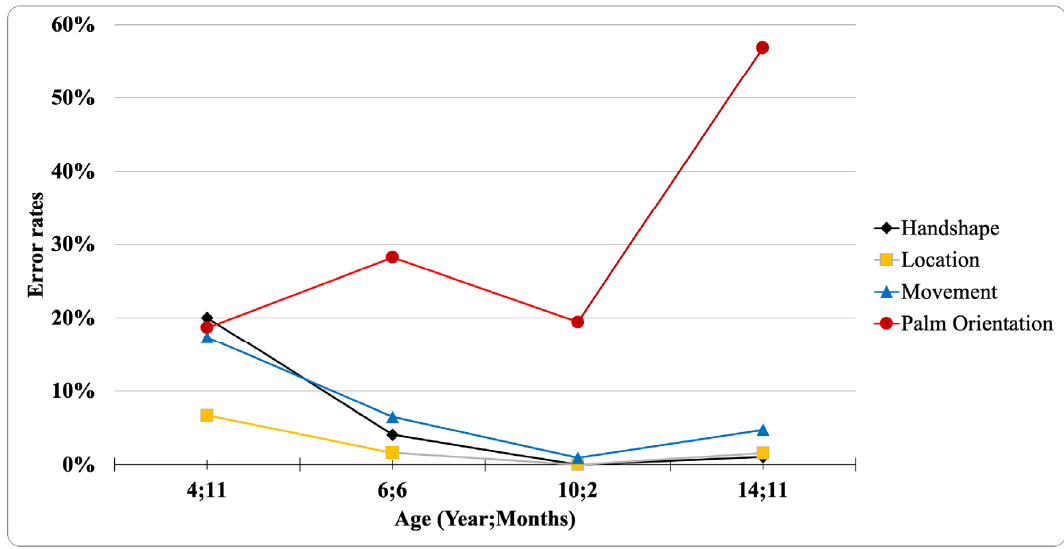
Figure 2. Proportion of signs exhibiting errors in the four sign parameters at four ages.